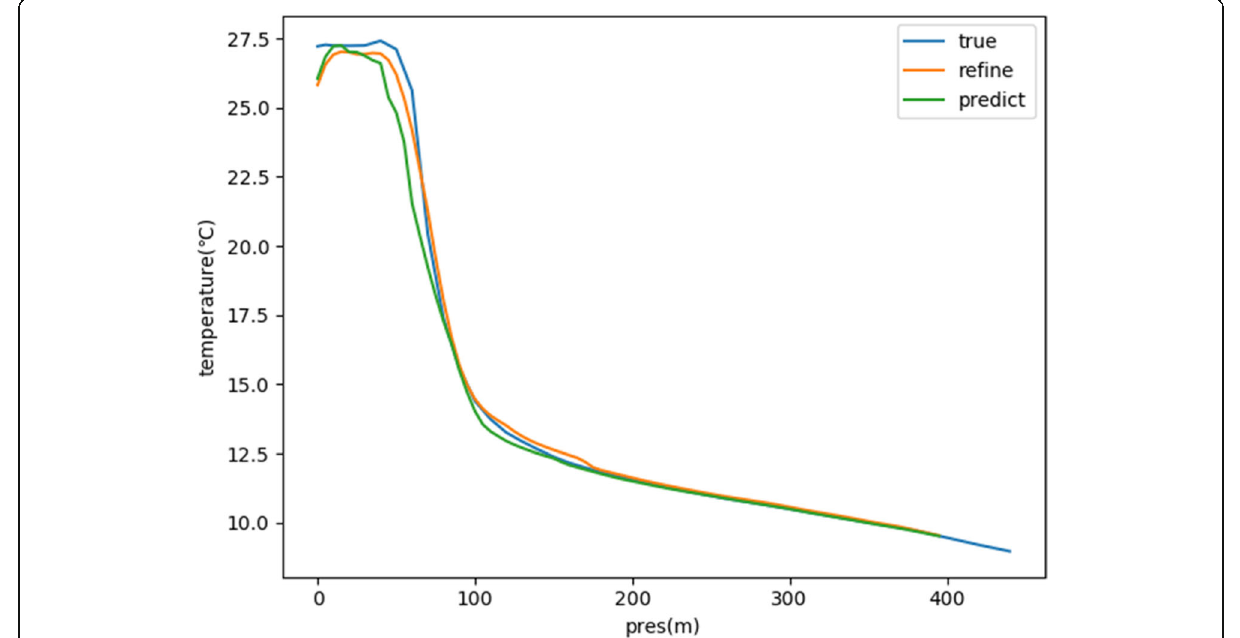
Fig. 6 Comparison for temperature variation curves of real data, high-resolution data, and prediction results on February